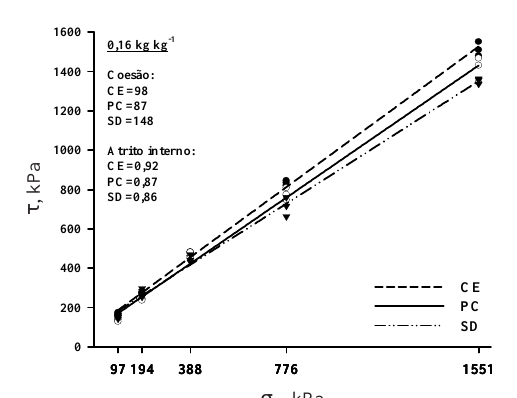
Figura 8. Relação linear simples entre a tensão normal ( σσσσσ ) e tensão cisalhante ( τττττ ) do Latossolo n Vermelho distrófico, sob cerradão (CE), preparo convencional (PC) e semeadura direta (SD), com seus respectivos parâmetros de intercepto de coesão e coeficiente de atrito, para a umidade de 0,27 kg kg -1